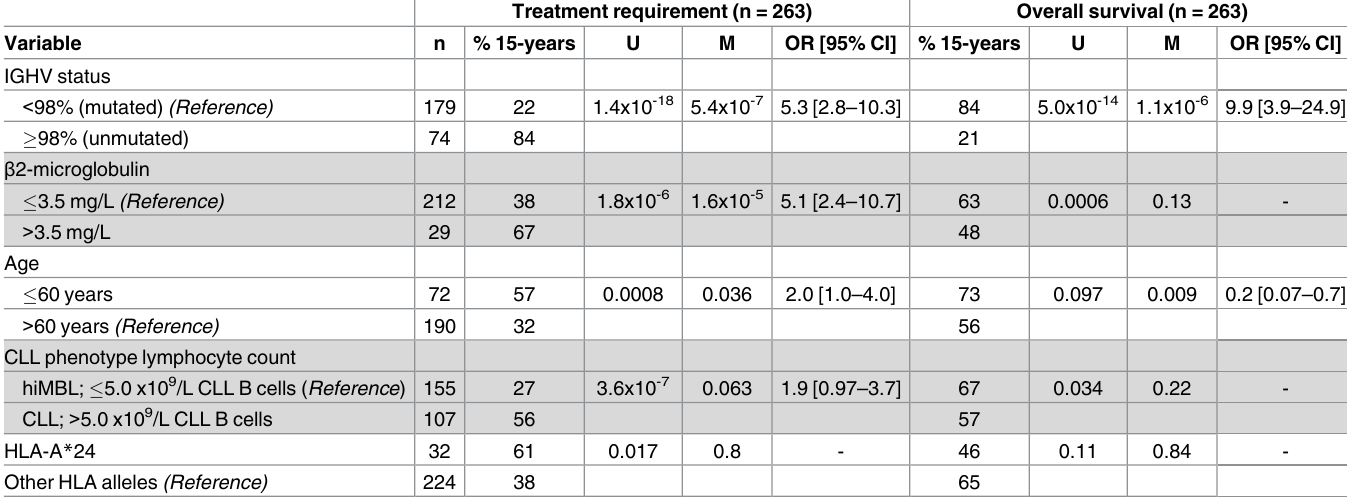
Table 2. Univariate and multivariate analysis of factors influencing outcome in hiMBL and Binet A CLL individuals. Treatment requirement (n = 263) Overall survival (n =